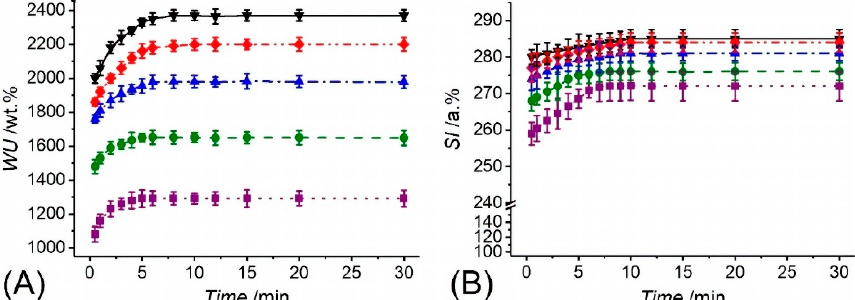
Figure 4. Water uptake ( WU , A ) and swelling index ( SI , B ) of thermally ‐ crosslinked PAA fibrous membranes following incubation at varied pH. ( ∙∙ ■ ∙∙ ): pH 5; ( ‐‐●‐‐ ): pH 6; ( ─ ∙ ▲ ∙ ─ ): pH 7; ( ─ ∙∙ ♦ ∙∙ ─ ): pH 7.4; ( ─▼─ ): pH